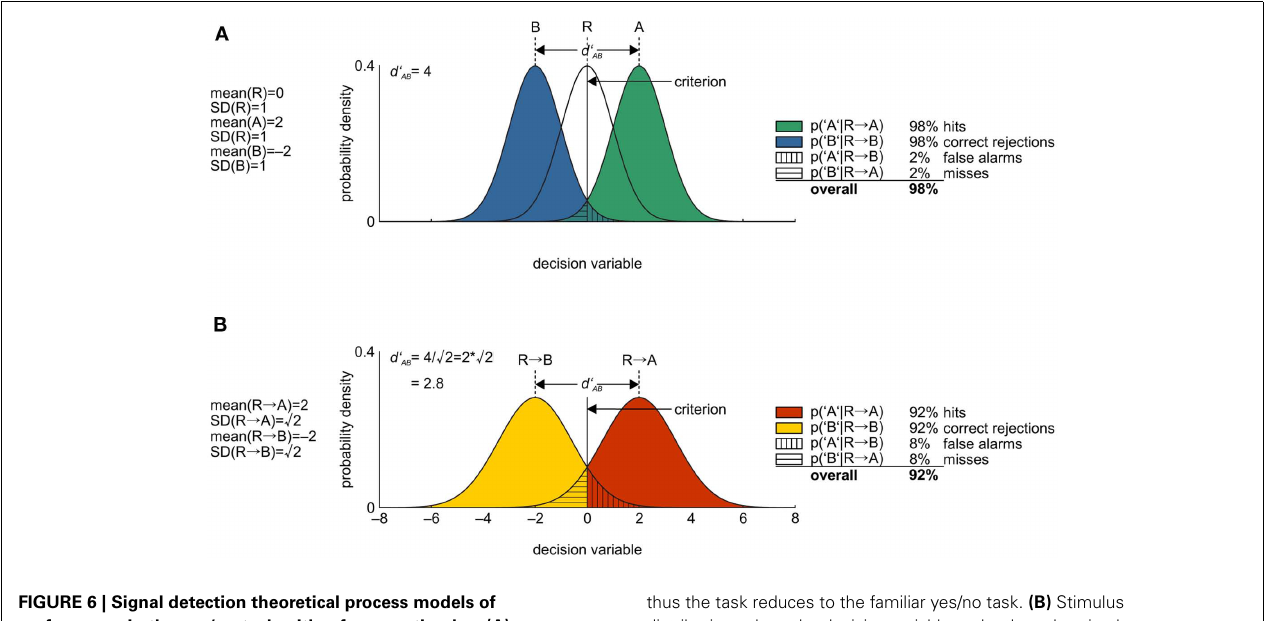
FIGURE 6 | Signal detection theoretical process models of performance in the yes/no task with reference stimulus. (A) Stimulus distributions along the decision variable under the optimal strategy.The reference stimulus sample is ignored on every trial, and